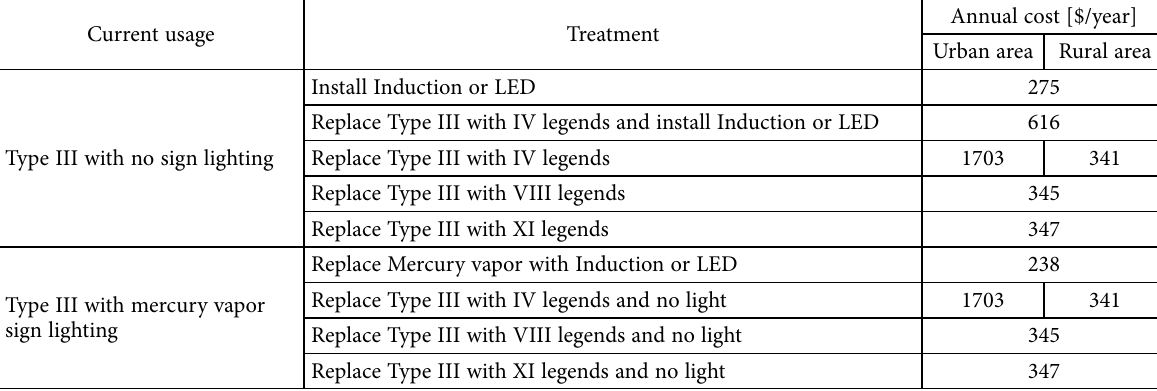
Table 8. Cost of different combinations of legend sheeting and lighting on straight and flat roadways Current